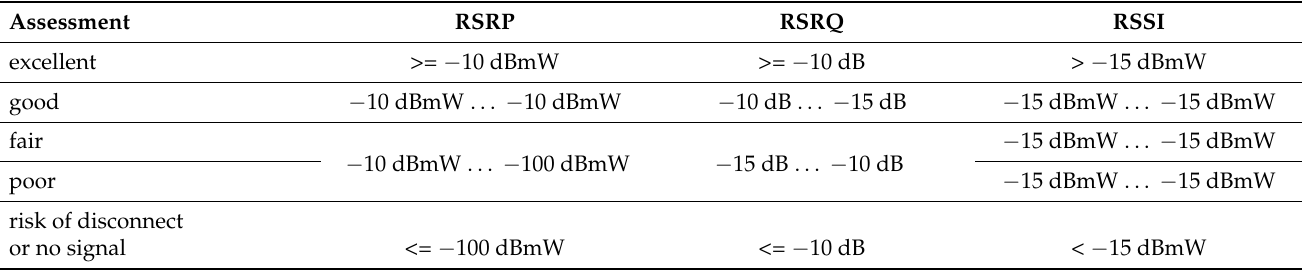
Table 4. LTE assessment criteria , based on [38].